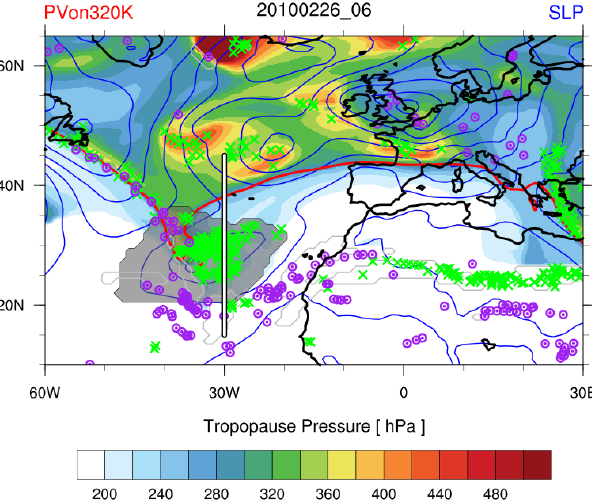
Figure 2. Pressure at the dynamical tropopause (in hPa, coloured), PV at 320K (red line), and contours of SLP (blue, contour inter- val 5hPa) at 06:00UTC 26 February 2010. Cyclone Xynthia, as identified by our method, is shaded gray. STT and TST events oc- curring within a 6h symmetric time window are depicted by green crosses and purple dotted circles, respectively. Gray contours indi- cate a folded tropopause (i.e., multiple vertical crossings). shall illustrate the combination of the cyclone and STE